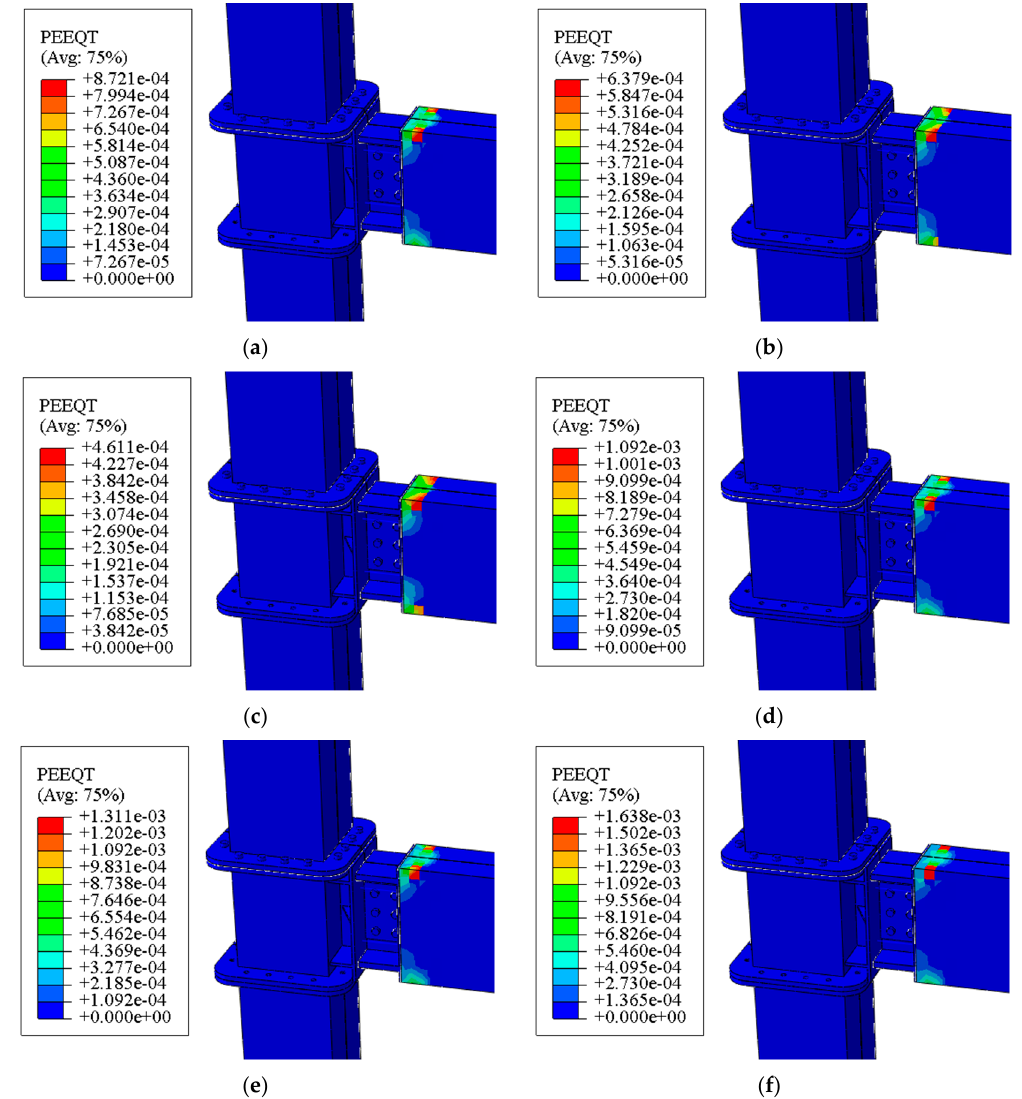
Figure 15. Comparison of joint failures: ( a ) J1-0; ( b ) J1-1; ( c ) J1-2; ( d ) J1-3; ( e ) J1-4; ( f ) J1-5. (PEEQT represents the equivalent plastic tensile strain, which indicates the degree of cracking of concrete).